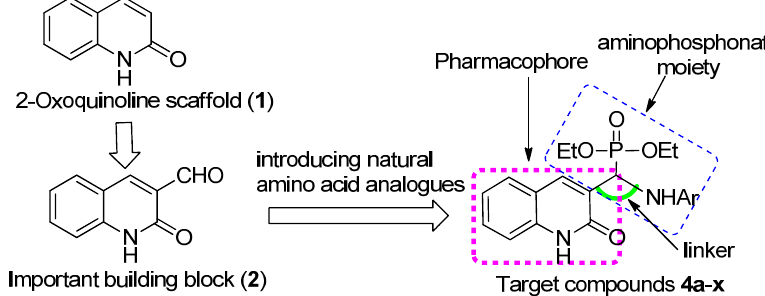
Figure 1. Design of novel α -aminophosphonates derivatives as anticancer agents.